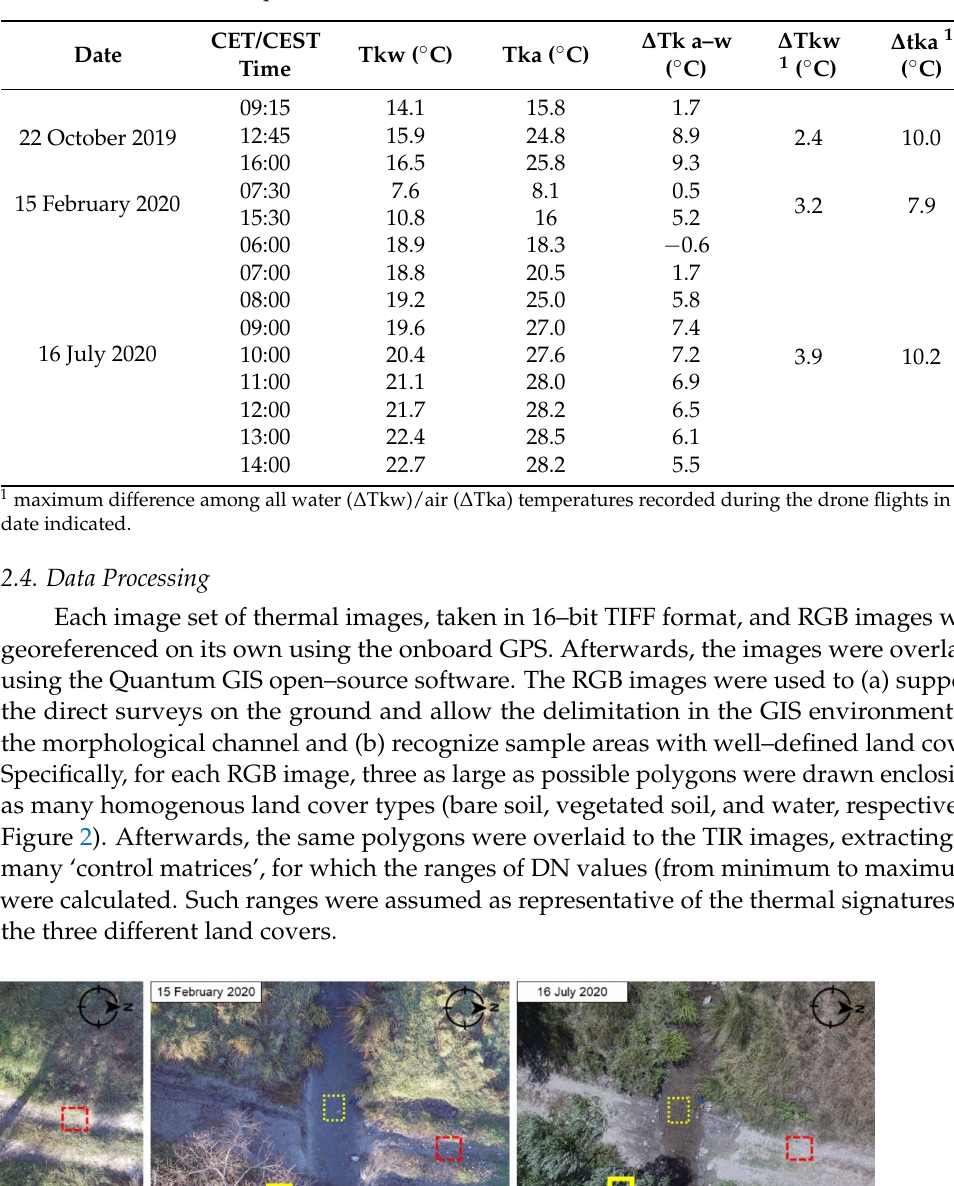
Table 3. Water and air temperature measurements.